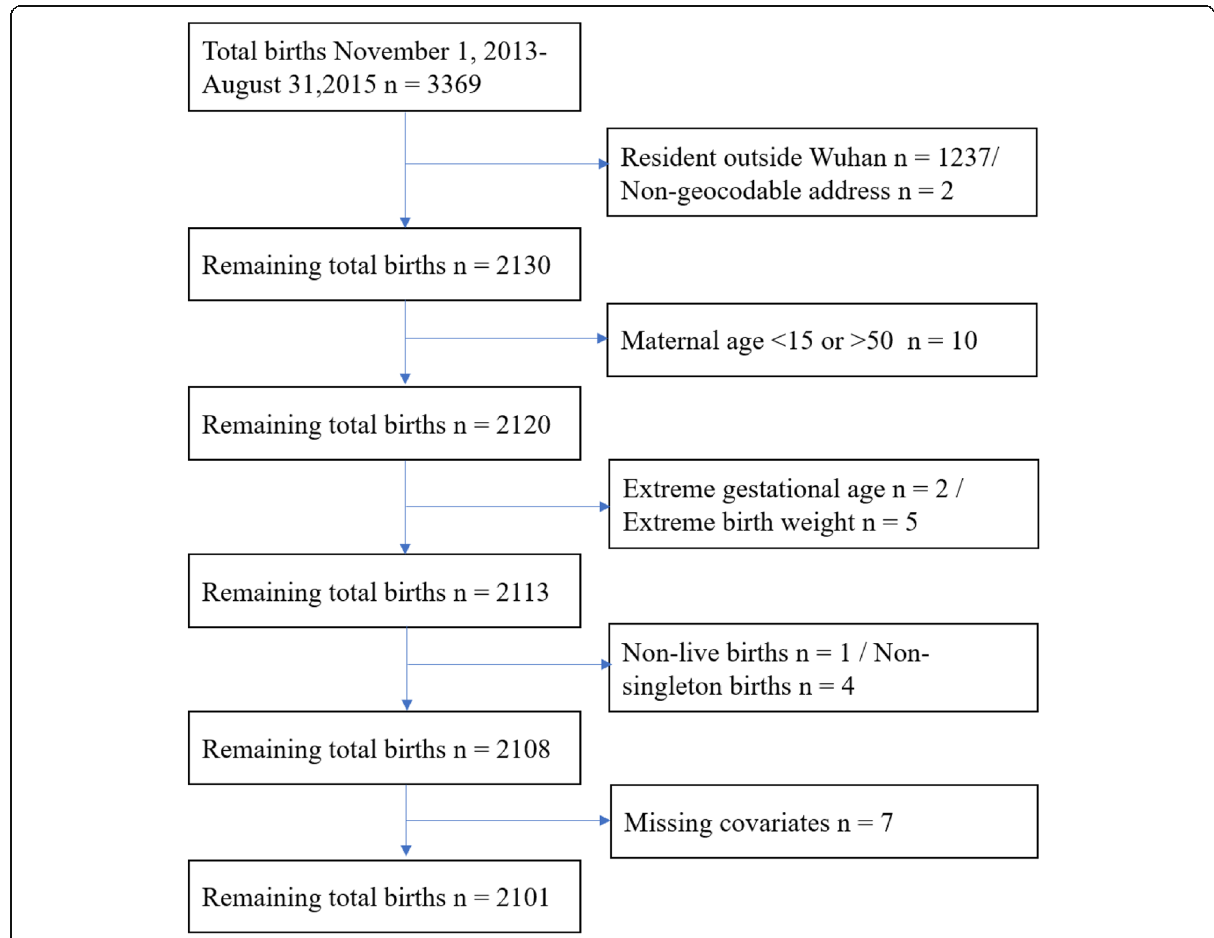
Fig. 1 Flow chart illustrating the selection process for the cohort study